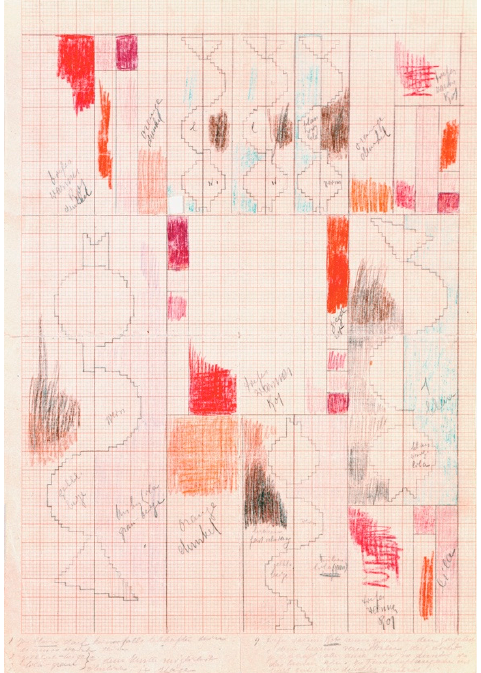
Figure 12. Sophie Taeuber-Arp, Untitled (embroidery design for Composition à motifs d’oiseaux), ca. 1927 – 1928. Pencil and colored pencil on graph paper. 25.8 cm × 37.5 cm. Private collection. Deposited in Aargauer Kunsthaus, Aarau (photo Peter Schälchli), used by permission.